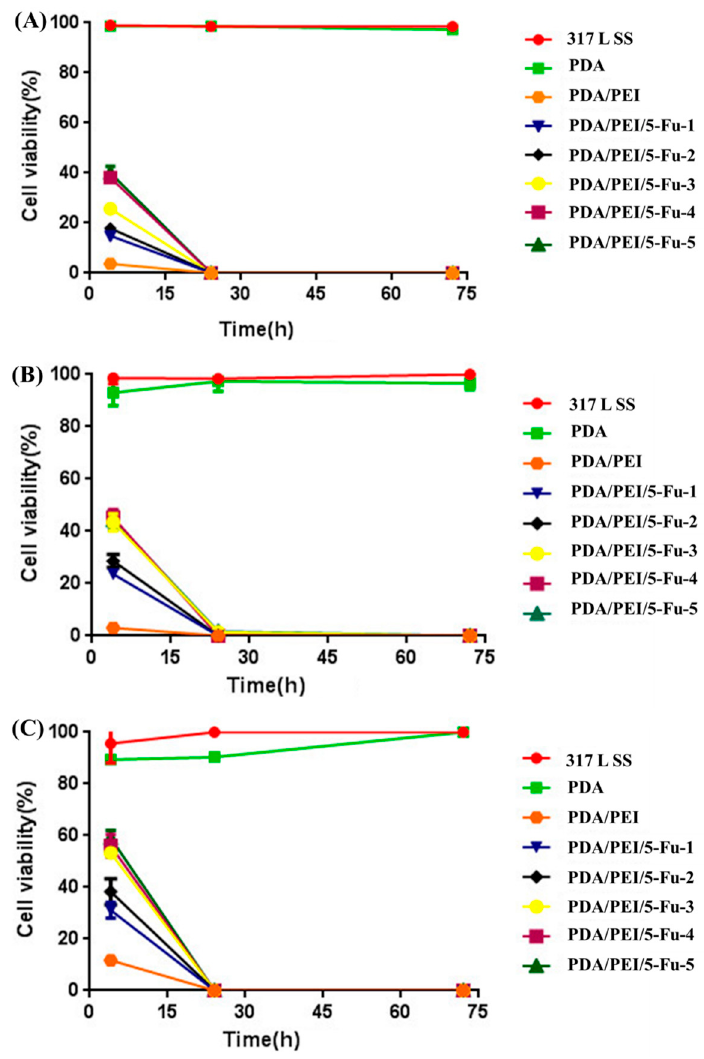
Figure 9. Statistical analysis of ( A ) Eca109, ( B ) Het-1A and ( C ) L929 cells apoptosis and necrosis (by counting cell viability) on the PDA/PEI/5-Fu layers and reference surfaces (mean ± SD, n = 3).